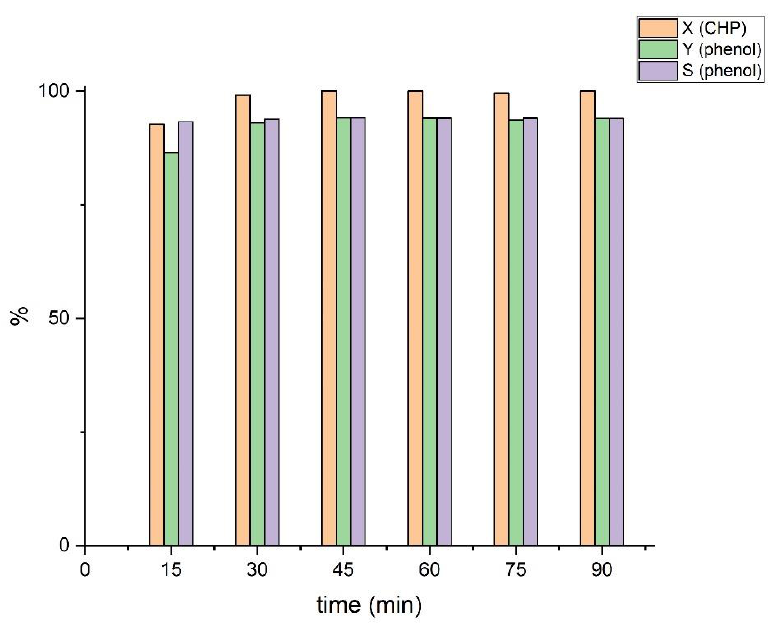
Figure 4. Yield of phenol in the Hock rearrangement of CHP in chloroform with different catalysts; 45 bar, 80 °C, 8.62 mL substrate.